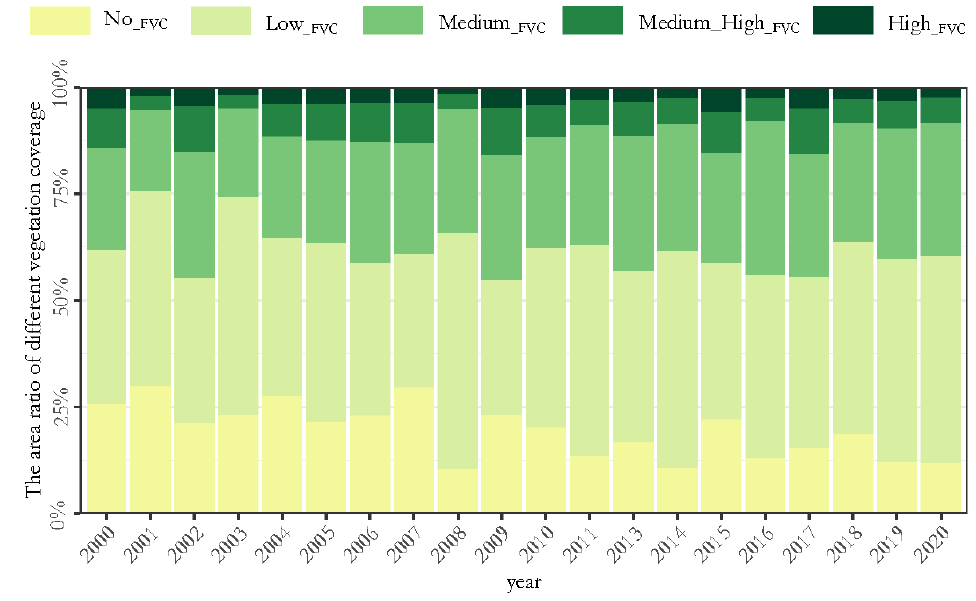
Figure 3. Annual changes in areas with a different FVC from 2000 to 2020.